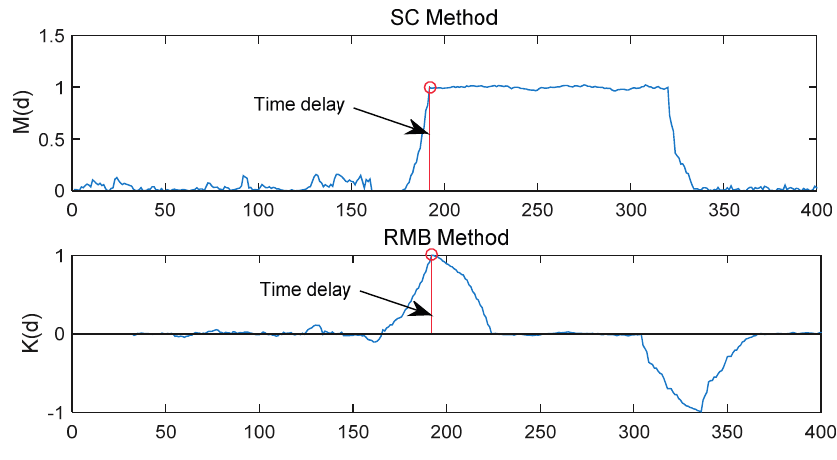
Figure 3. M ( d ) of SC method and K ( d ) of RMB